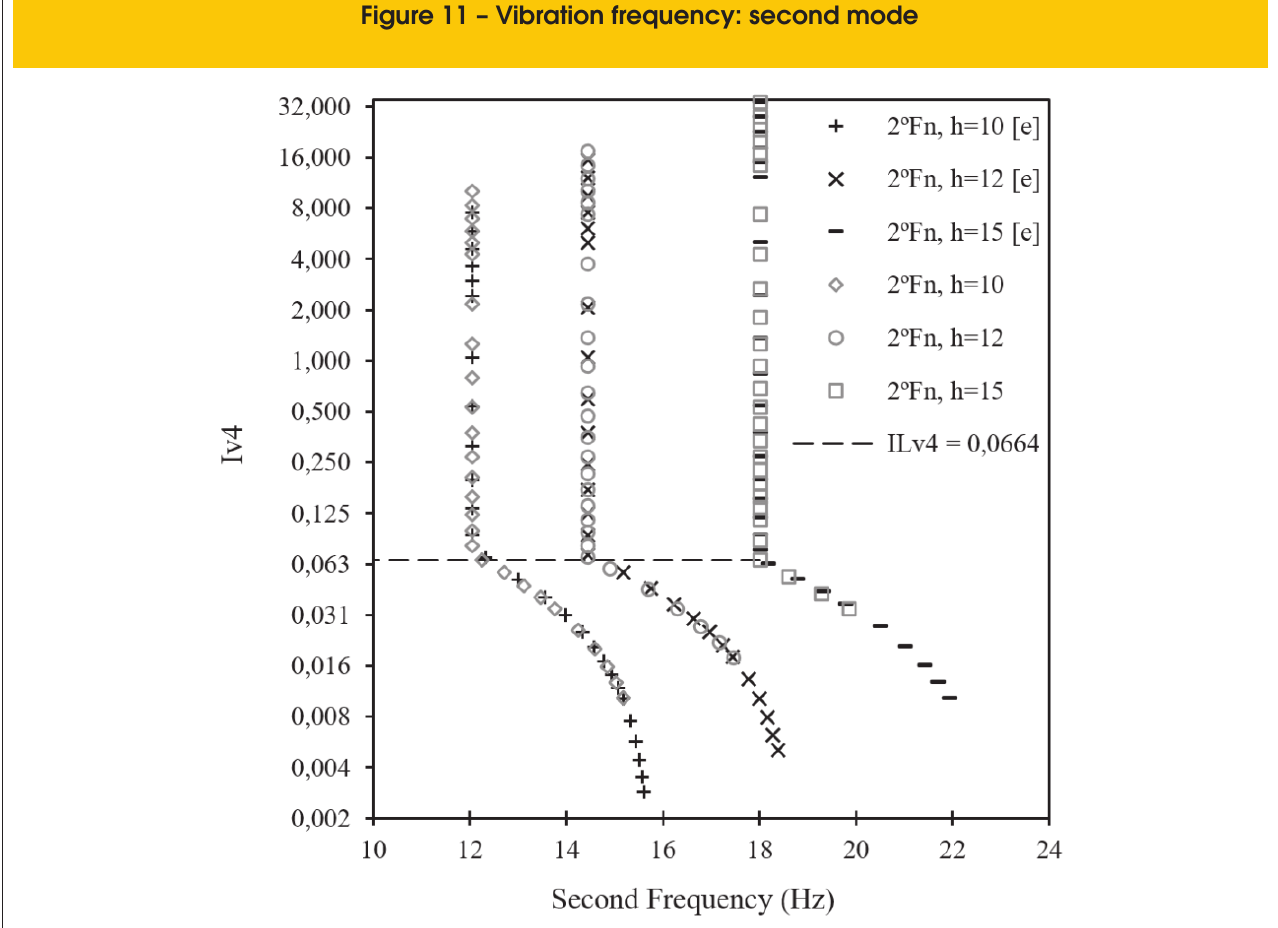
Figure 11 – Vibration frequency: second